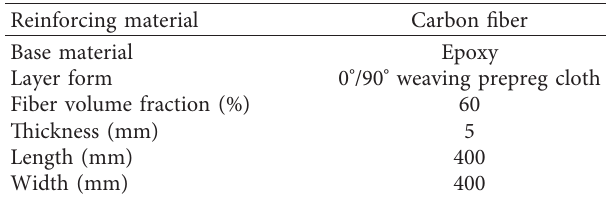
Table 1: The properties of CFRP.